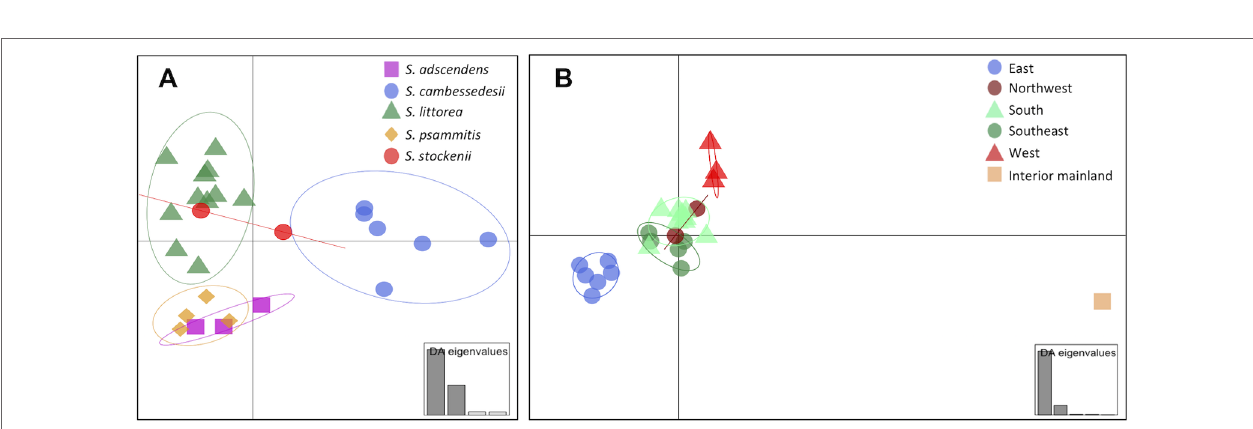
FIgURe 5 | Scatter plot of Discriminant Analysis of Principal Components (DAPC) when using species and location categories as priors. In the scatter plot using species categories as priors (a) , each species is represented by different symbols and colors ( S. adscendens , pink square; S. cambessedesii , blue circle; S. littorea , green triangle; S. psammitis , orange diamond; S. stockenii , red circle). In the scatter plot using geographic location categories as priors (B) , each location is represented by different symbols and colors (northwest, dark red circles; west, red triangles; south, green triangles; southeast, dark green circles; east, blue circles; interior mainland, brown square). The 95% inertial ellipses around each cluster represent the variance of the two first principal components of the DAPC. The insets represent the relative magnitude of the eigenvalues of the first four and five principal components, respectively.